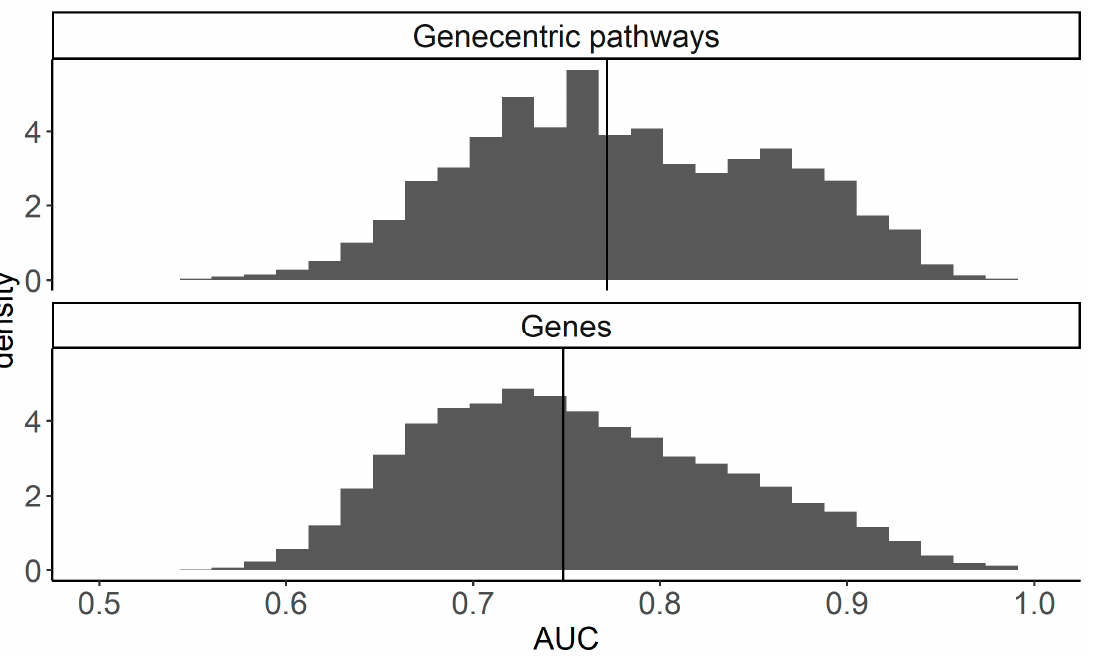
Figure 12. Pathway activation charts for marker pathways in mesenchymal vs. proneural GBM mo- lecular subtypes. LAMB1-centric pathway: TCGA ( A ), CGGA_325 ( B ), and CGGA_693 ( C ) expres- sion datasets. Nodes on panel A correspond to nodes on panels B and C. CD300E-centric pathway, TCGA ( D ), CGGA_325 ( E ), CGGA_693 ( F ) expression datasets. Node activation was calculated as a logarithmic ratio of geometric mean of expression levels in the GBM subgroups under analysis.